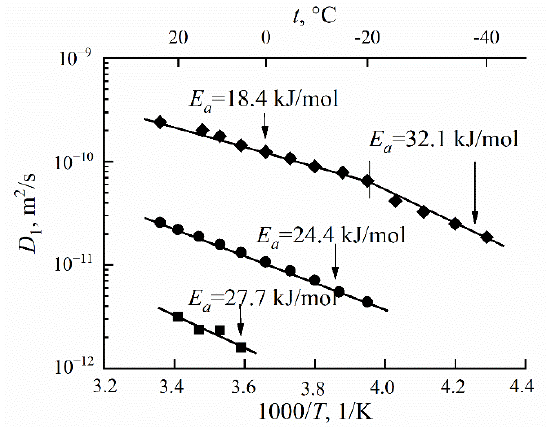
Figure 29. Temperature dependences of the self-diffusion coefficients D measured by PFG NMR at different water contents in the acid form of the MSC membrane: λ = 5.1 ( 1 ), 7 ( 2 ), 8.4 ( 3 ). Reprinted with permission from Ref. [34]. Copyright © 2022 Pleiades Publishing, Ltd.